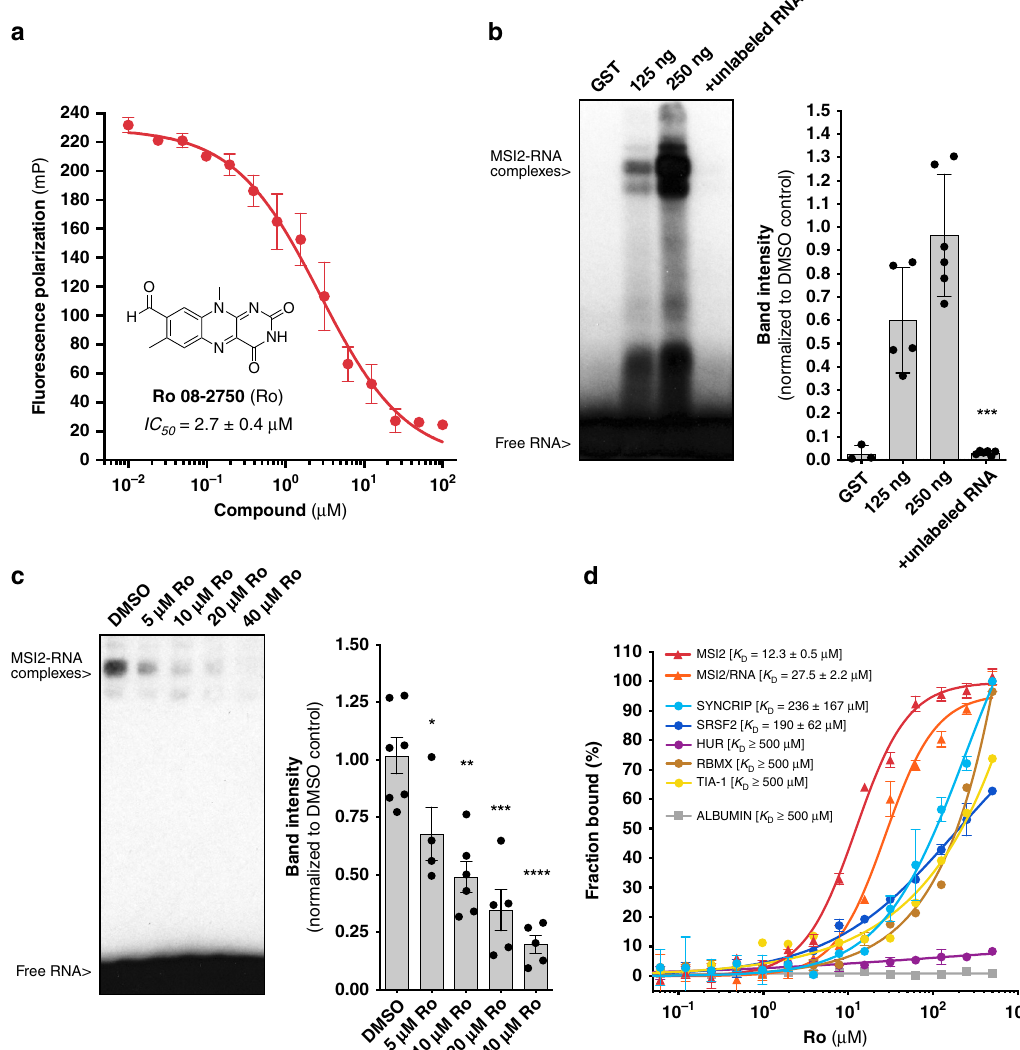
Fig. 1 Ro 08 – 2750 (Ro) is a selective MSI RNA-binding activity inhibitor. a Fluorescence polarization secondary validation of Ro 08 – 2750 (Ro) IC 50 for MSI-RNA binding inhibition in 384-well format. Seven independent experiments performed in duplicate ± standard error mean (s.e.m.) are shown; ( b ) Representative Electrophoresis Mobility Shift Assays (EMSA) for GST-MSI2 and GST-MSI2 proteins (125 and 250 ng) using biotinylated-RNA oligo in the absence or presence of unlabeled RNA (left); quanti fi cation of MSi2-RNA complexes of fi ve independent experiments ± s.e.m. is shown in bar graph (right); ( c ) EMSA for GST-MSI2 (125 ng) in the presence of increasing concentrations of Ro (5 to 40 μ M); quanti fi cation of RNA-protein complexes of at least four independent experiments ± s.e.m. is shown in bar graph (right); ( d ) Microscale Thermophoresis (MST) assay with interaction of Ro and GST-MSI2 (red), GST-MSI2/RNA complexes (orange) and the RRM-based RBP controls GST-SYNCRIP (light blue), GST-SRSF2 (dark blue), GST-HUR ( purple ), GST-RBMX (brown) and GST-TIA − 1 ( yellow ) and non-RBP control bovine serum ALBUMIN (gray). Ro concentrations ranged from 0.0153 to 500 μ M. Af fi nity ( K D ) values ± s.e.m. ( μ M) of at least three independent experiments are shown as percentage of fraction bound. For b and c : two-tailed Paired t -test; * p < 0.05; ** p < 0.01, *** p < 0.005, **** p < 0.001. Source data are provided as a Source Data fi